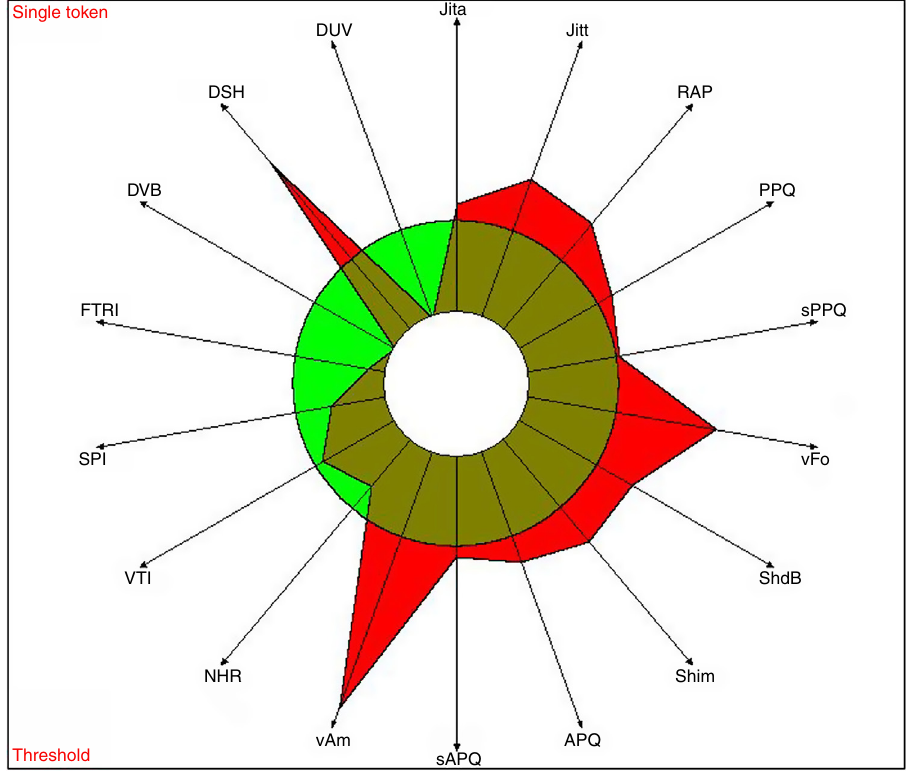
Figure 2 Multidimensional voice program (MDVP) underlines preoperatory perturbations in frequency and